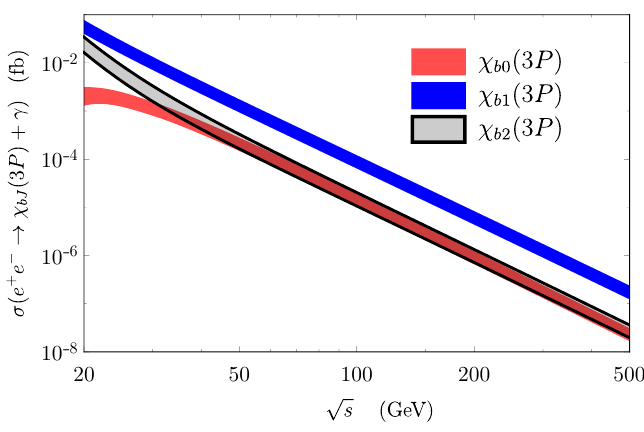
Figure 4 . Predicted cross sections (cid:27) ( e + e (cid:0) ! (cid:31) bJ (3 P ) + (cid:13) ) for J = 0 (red band), J = 1 (blue band), and J = 2 (grey band with black